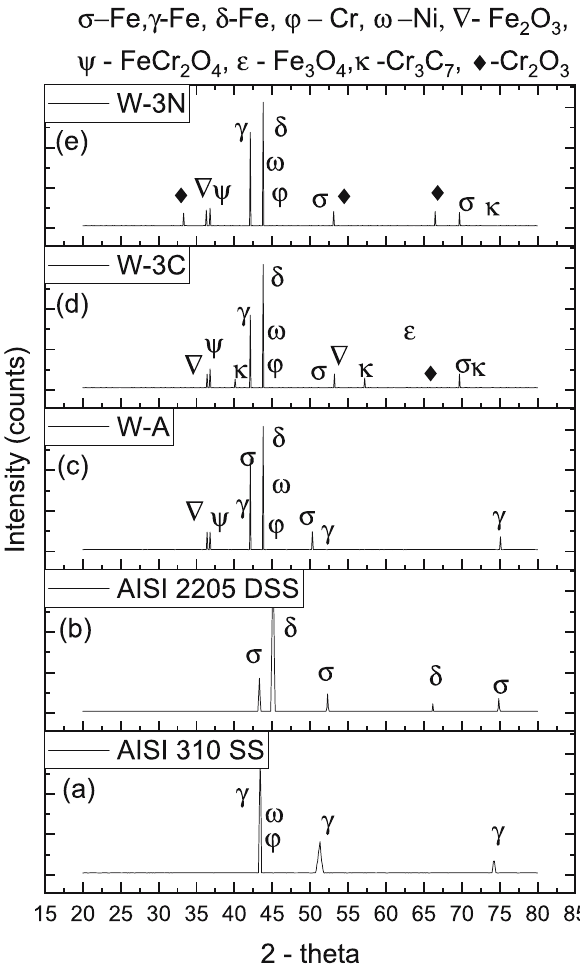
Figure 6: X - RD analysis graphs of ( a ) AISI 310 SS, ( b ) AISI 2205 DSS, ( c ) W - A, ( d ) W - 3C, and ( e ) W - 3N